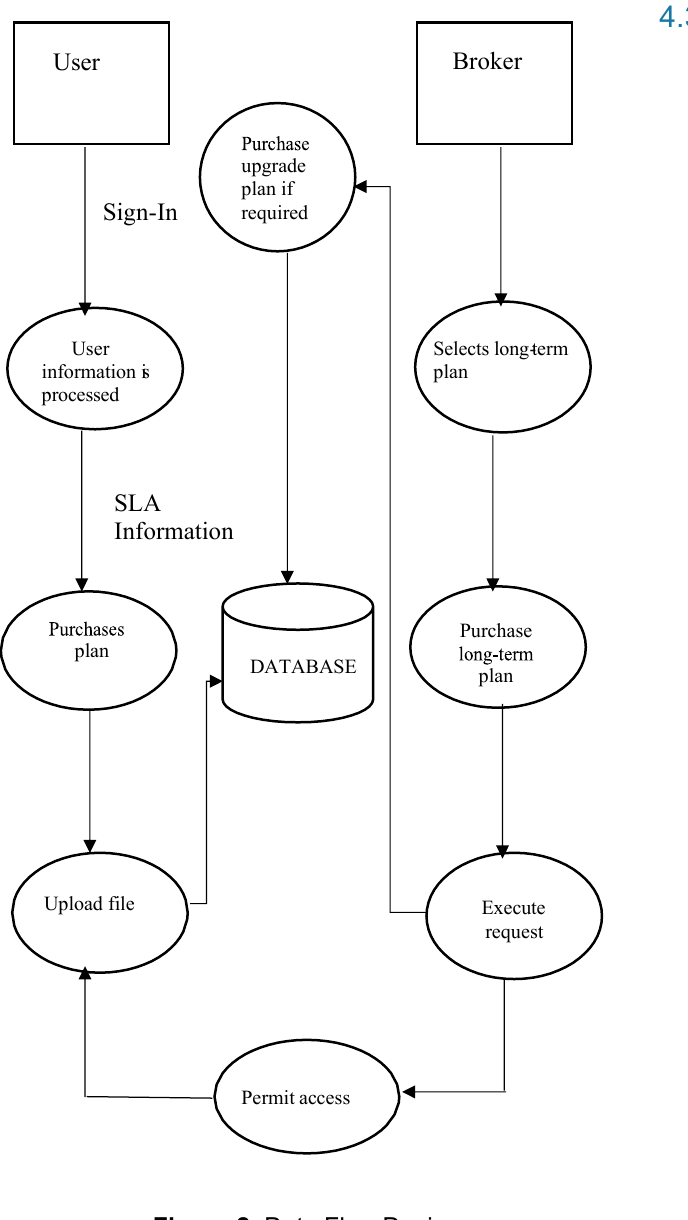
Figure 2. Data Flow